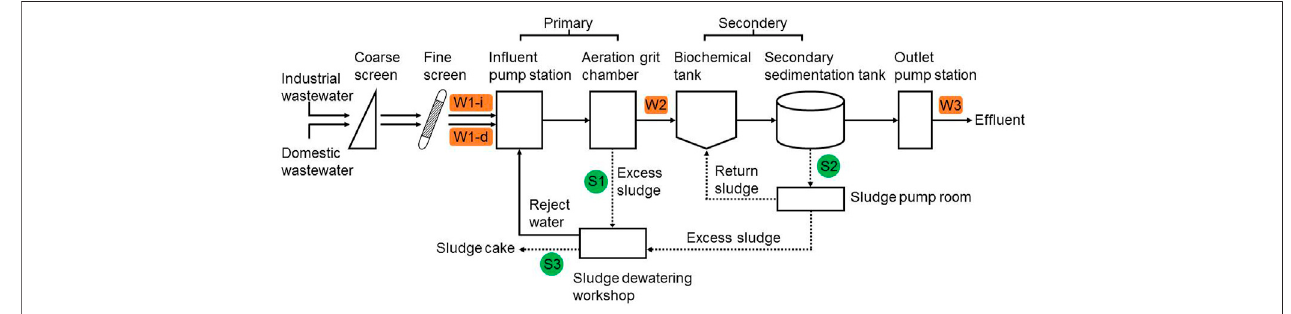
FIGURE 1 | Schematic of Haicang WWTP and sampling sites in 2018.